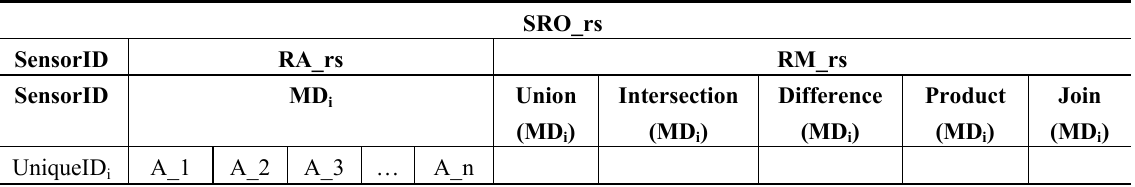
Table 3. Logical structure of remote sensing sensor resource